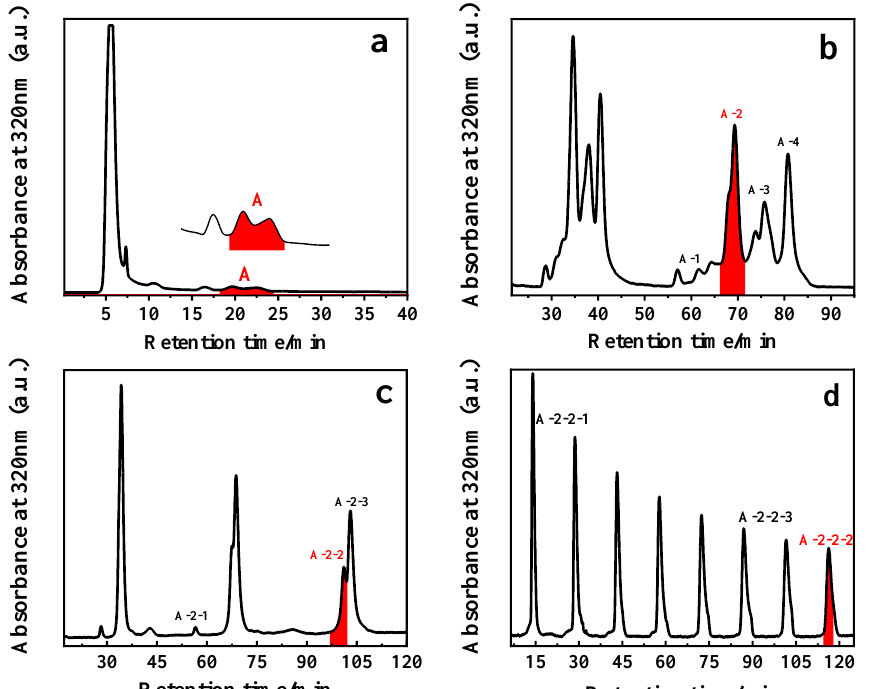
Figure 1. Isolation and purification of Dy@C 80 (CH 2 Ph) via four-step HPLC process. ( a ) Collected fraction A contained Dy@C 80 (CH 2 Ph) and labelled as the red region. Conditions: Buckyprep column (ø 10 × 250 mm), a flow rate of 4 mL/min, injection volume of 4 mL, toluene as eluent at 40 °C. ( b ) Recycling HPLC profile of fraction A for fraction A-2. Conditions: Buckyprep column (ø 20 × 250 mm), a flow rate of 8 mL/min, injection volume of 8 mL, toluene as eluent at 40 °C. ( c ) Recycling HPLC profile of fraction A-2 for A-2-2. Conditions: Buckyprep column (10 × 250 mm), a flow rate of 4 mL/min, injection volume of 4 mL, toluene as eluent at 40 °C. ( d ) HPLC profile of fraction A-2-2 for consequence A-2-2-2. Conditions: Buckyprep-M column (10 × 250 mm), a flow rate of 4 mL/min, injection volume of 4 mL, toluene as eluent at 40 °C.